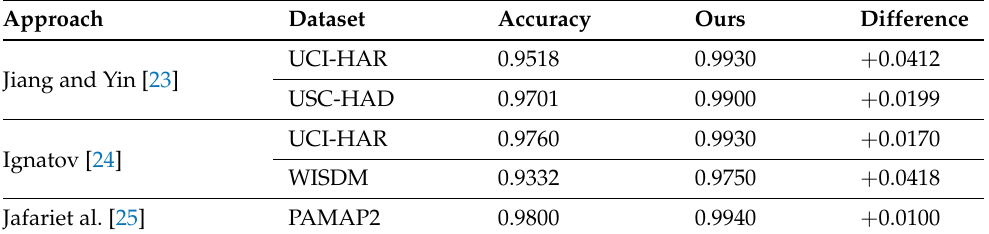
Table 1. Performance: our approach vs. other existent image representation approaches for Activ- ity